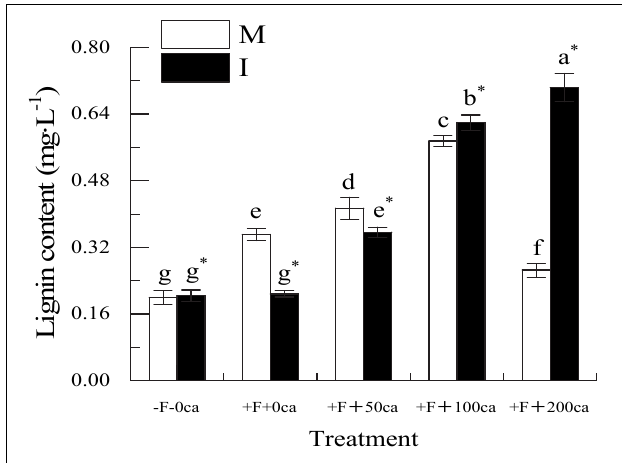
FIGURE 5 | Effects of FOF and cinnamic acid stress on lignin in the stems of faba bean ( Vicia faba ) and the effect of intercropping. Values in the figure are the mean ± standard error. Different lowercase letters after data indicate significant difference ( P < 0.05). ∗ Significant differences between monocropping and intercropping treatments at the same FOF and cinnamic acid levels ( P < 0.05). ca, cinnamic acid; FOF, Fusarium oxysporum f. sp. fabae ; I, intercropped; M,